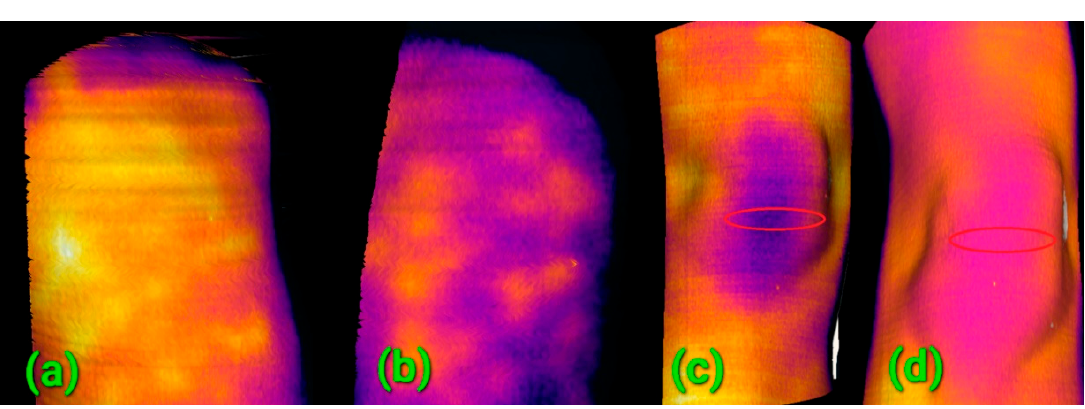
Figure 14. An upper limb a ff ected by entezopathy of the deltoid muscle at ( a ) the first visit and ( b ) the second visit; the healing of the inflammation is clearly observable. The recovery following a surgery of ruptured knee ligaments at ( c ) the first visit and ( d ) the second visit; improved blood circulation is visible. Note: the regular hot spots in ( a , b ) are caused by cellulite.